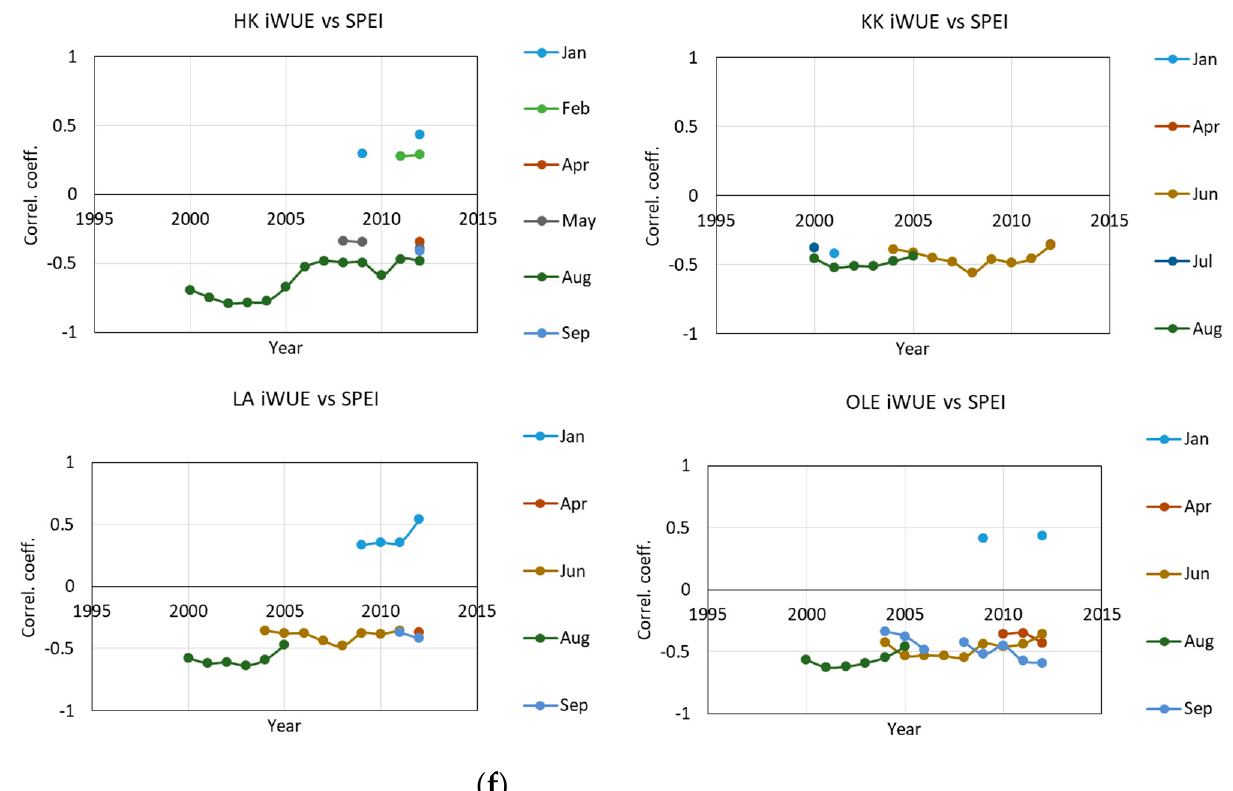
Figure 5. The impact of climate changes on fractionation of carbon isotopes in pine grown in four forests in Silesia (Poland): HK − Dabrowa Górnicza, LA − Ł aziska Górne, KK − K ę dzierzyn Ko ź le, OLE − Olesno. Relationship between δ 13 C and monthly mean air temperature (T) ( a ), monthly sum of precipitation (P) ( b ), standardized precipitation − evapotranspiration index (SPEI) ( c ) and iWUE between monthly mean air temperature ( d ), monthly sum of precipitation ( e ) and standardized precipitation-evapotranspiration index ( f ). The results of the temporal stability test of the correlation between climatic parameters and δ 13 C and iWUE based on the bootstrap correlation and the moving interval correlation (base length 26 years, last year was indicated on the x − axis). The investigated period of time was from September (capital letter) of the previous year until September of a given year, p < 0.05, investigated cover period of time: 1975–2012).